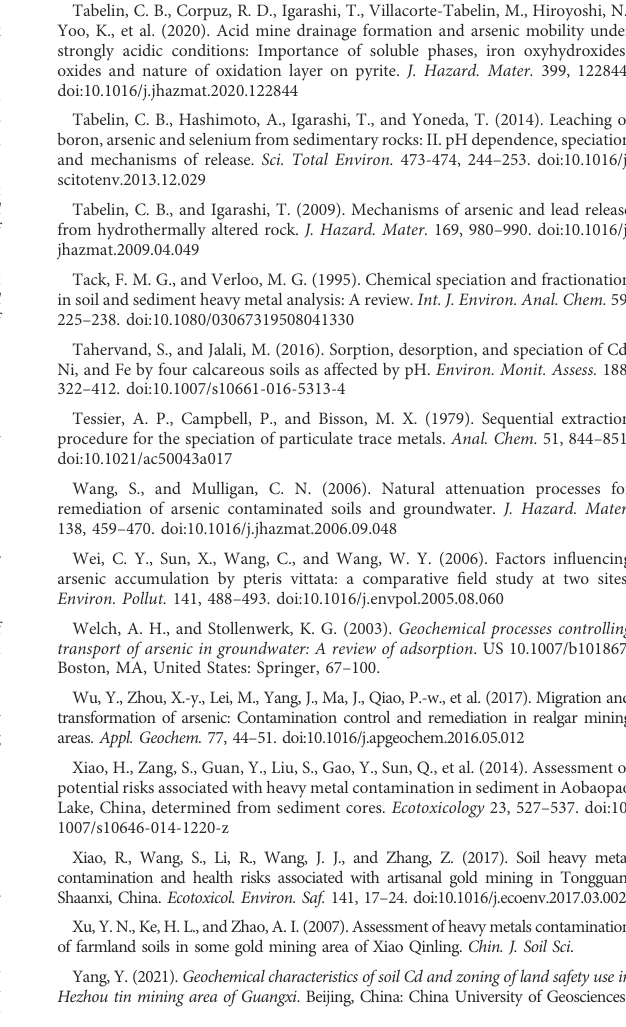
Tabelin, C. B., Corpuz, R. D., Igarashi, T., Villacorte-Tabelin, M., Hiroyoshi, N., Yoo, K., et al. (2020). Acid mine drainage formation and arsenic mobility under